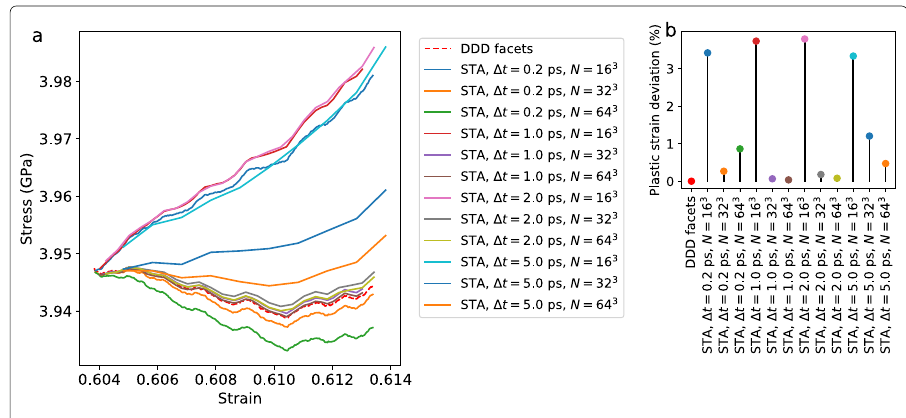
Fig. 9 Effect of the choice of STA parameters (cid:2) t and N on the accuracy of STA method when applied to a DDD simulation trajectory. a “Exact” stress-strain response from the DDD simulation (dashed red line) compared to stress-strain responses reconstructed from the STA facets obtained using various parameter values for (cid:2) t and N (see the legend). b Average deviation from the “exact” DDD plastic strain of plastic strain reconstructed from the STA facets extracted using different STA parameter values